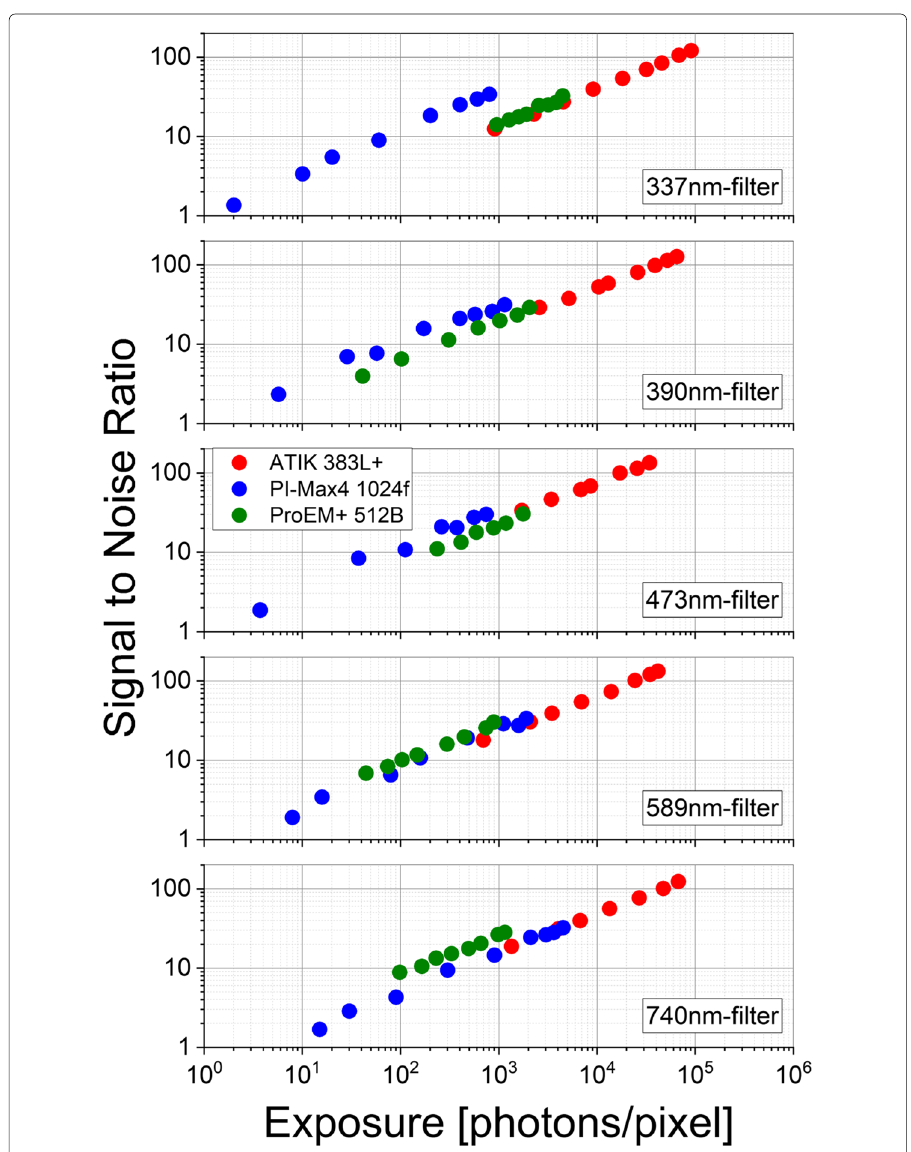
Fig. 10 The SNR of the three camera systems is shown versus the exposure per pixel for the filters which have been used to select the wavelengths. The exposure per pixel describes the actual number of photons reaching one pixel of the camera chip (see also text)